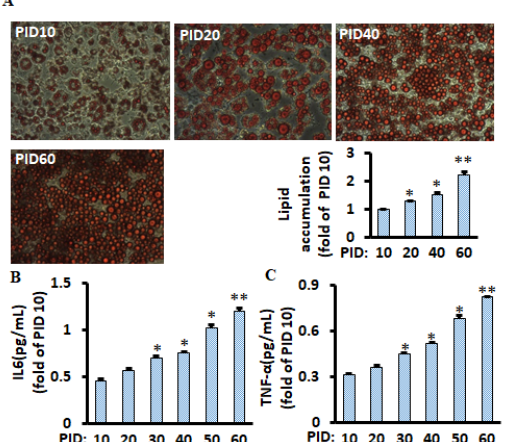
Figure 1. Lipid accumulation and pro-inflammatory markers chronologically increased during the 60 days in differentiated 3T3-L1 adipocytes with conditioned medium. Representative images of lipid accumulation (Oil Red O staining) at relevant days are shown ( A ), and lipids were measured using a spectrophotometer, and a bar graph is shown. Pro-inflammatory markers IL-6 ( B ) and TNF- α ( C ) of differentiated adipocytes were measured using the ELISA kit. Data were analyzed using one-way ANOVA, and significant differences were further analyzed using Tukey’s test; * p < 0.05, ** p < 0.01 compared to PID 10.